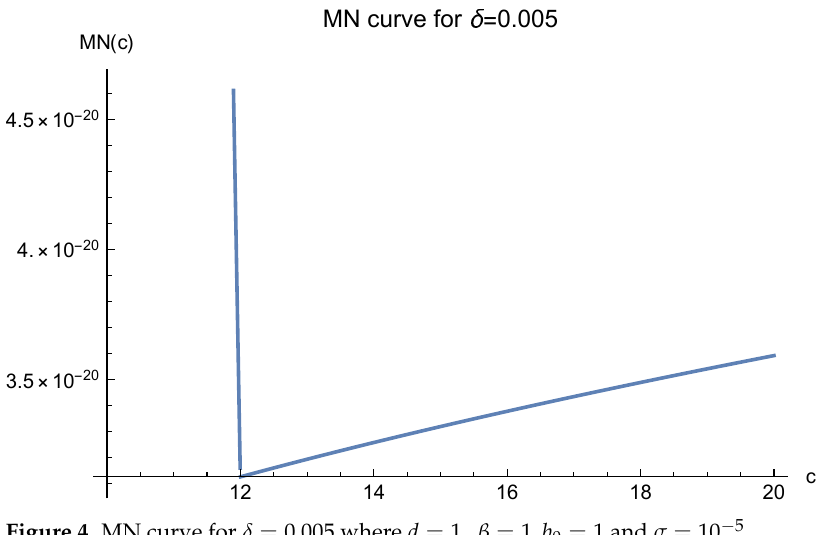
Figure 3. MN curve for δ = 0.001 where d = 1, β = 1, b 0 = 1 and σ = 10 − 1 .